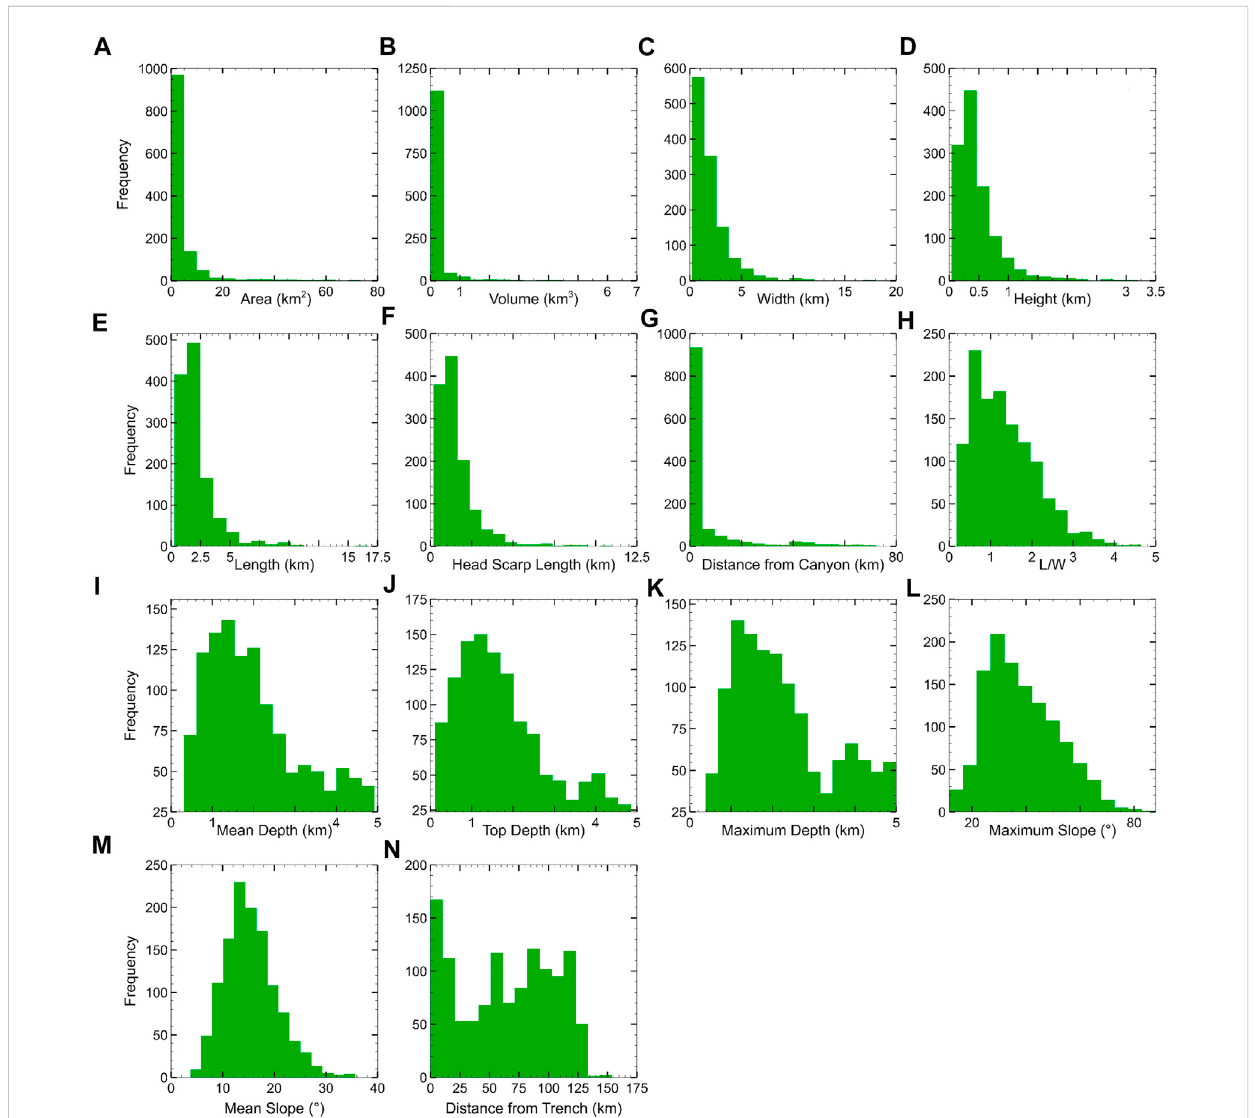
FIGURE 7 Histograms of submarine landslide morphometric parameters. (A) Area, (B) volume, (C) width, (D) height, (E) length, (F) head scarp length, and (G) distancefromsubmarinecanyonsfollowapower-lawdistribution,re fl ectingtheubiquitoussmallsubmarinelandslides. (H) L/Wratio, (I – K) depth, and (L, M) slope show a positively skewed binomial distribution. On the other hand, the (N) distance from the trench has an irregular